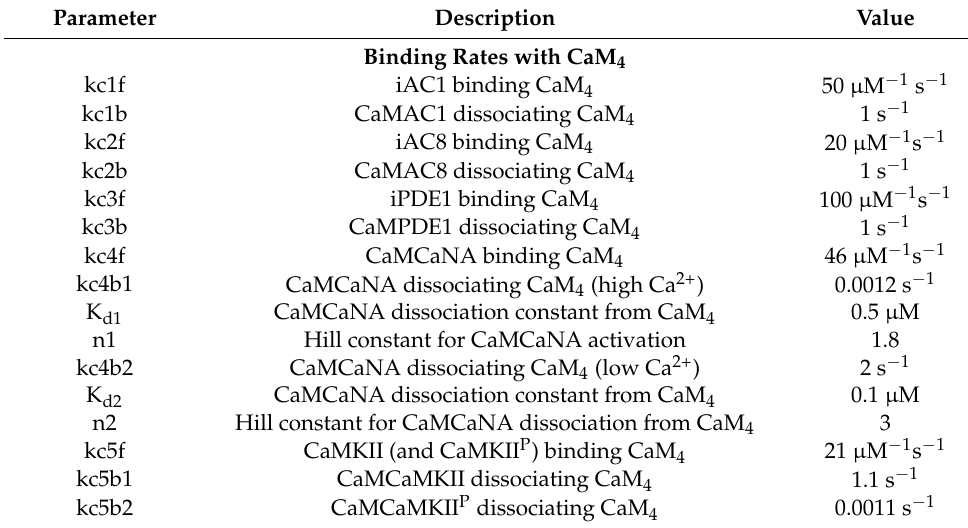
Table 3. Parameters used and values used in the full CaM model. All values used are from